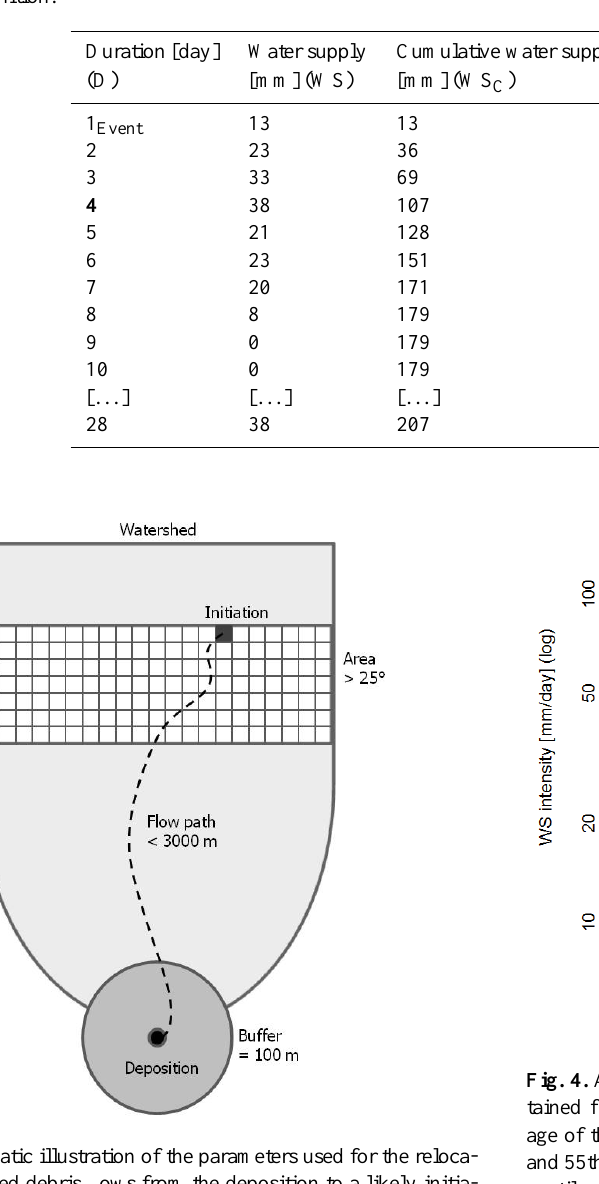
Table 1. Individual series of antecedent water supply data for a debris flow event that occurred near Vang (central Norway) on 04.05.2008: The cumulative water supply [mm] and the corresponding average intensities [mmday − 1 ] are calculated for the 28 days in advance of an event. The found maximal cumulative average intensity (WS C /D) and the corresponding duration (D) (printed bold) are used as input for the threshold definition.